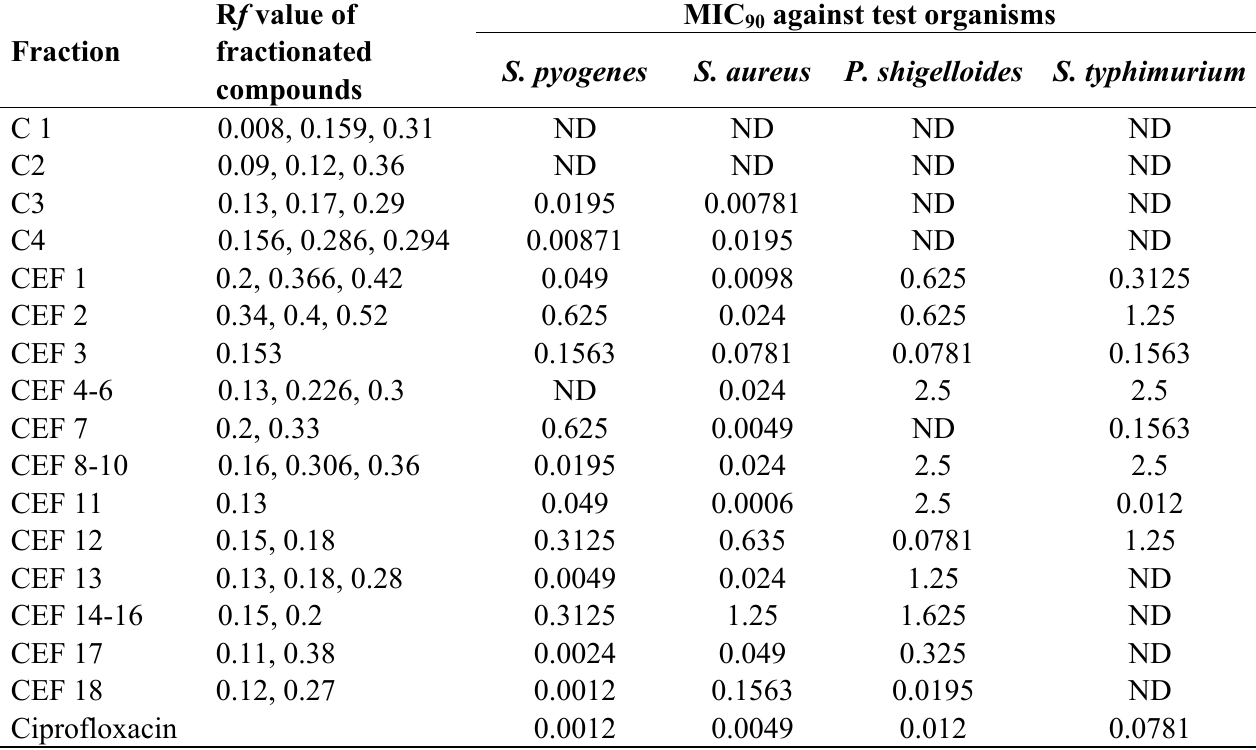
Table 5. R values of fractionated compounds and MICs in mg/mL against test f